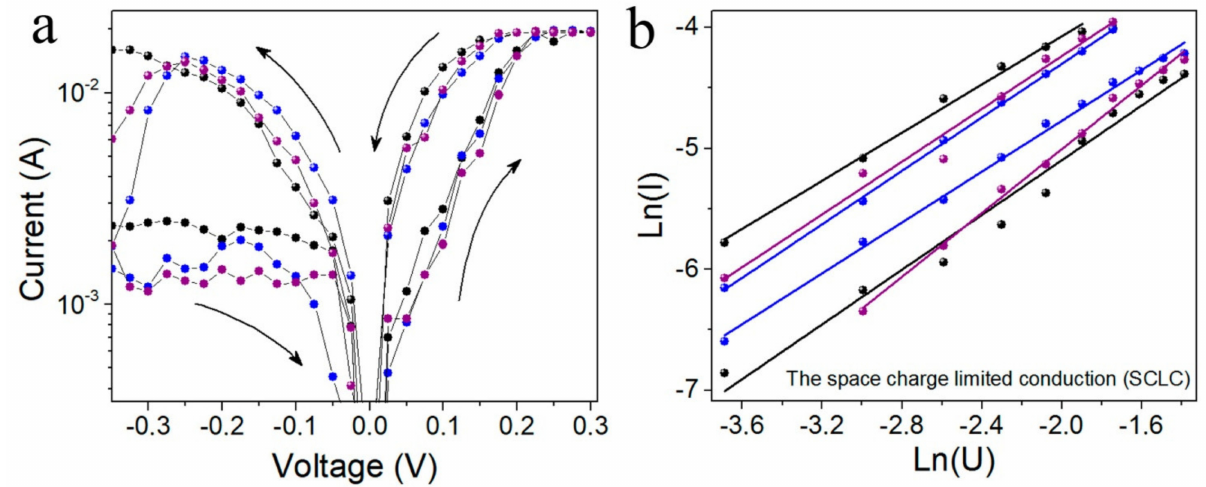
Figure 6. ( a ) Current-voltage characteristics for the printed Ag–FG–PVA–Ag crossbar structure measured after the irradiation by Xe ions with the energy of 167 MeV and the fluence 3 × 10 10 cm − 2 . ( b ) The ON-state current in the coordinate of the space charge limited conduction (SCLC) ln(I) versus ln(V) for a few measurements given in ( a ).